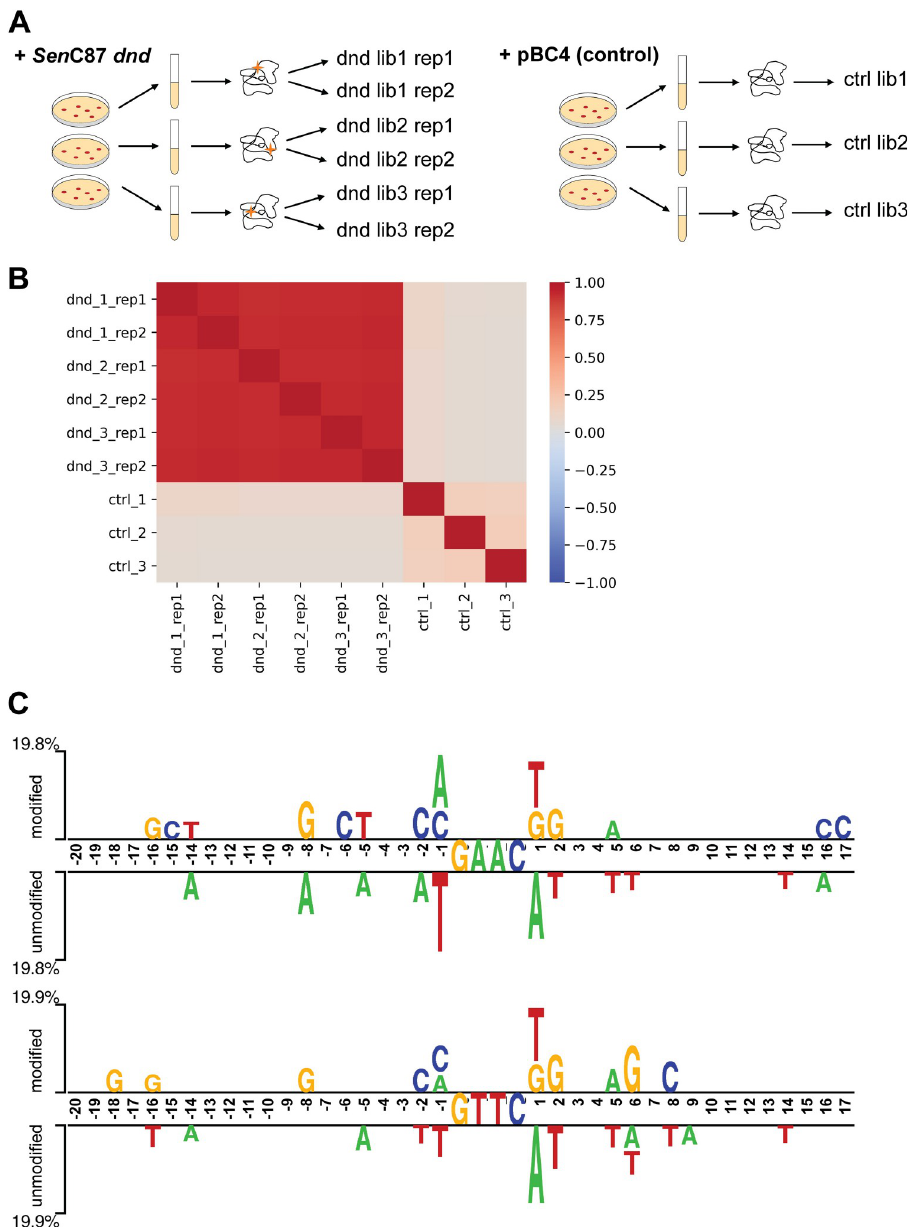
Fig 4. Investigation of target modification sites in E . coli heterologous PT modifying system. ( A ) Experiment design. Stars represent PT modifications in the genome. ( B ) Correlations among the 6 Sen C87 dnd /pBC4 transformed E . coli strains. For each pair of comparisons, modification scores of all possible GAAC/GTTC sites were used for correlation calculation. Color bar on the side indicated the Pearson correlation values. For Sen C87 dnd transformed E . coli strains, correlations were also performed among the technical duplicates (rep1 and rep2). ( C ) Output of Two Sample Logo [31]: Graphical representation showing statistically significant (p value < 0.01) differences in position- specific symbol compositions between modified and unmodified GAAC positions (top) and modified and unmodified GTTC positions (bottom) in E . coli .